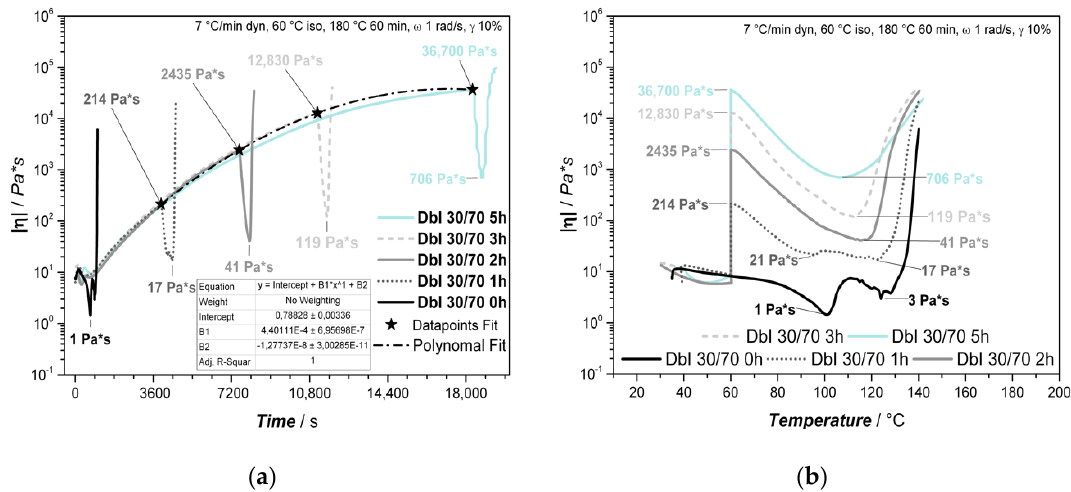
Figure 7. Investigations of the DbI 30/70 w system with different pre-curing times at 60 °C with process-related heating